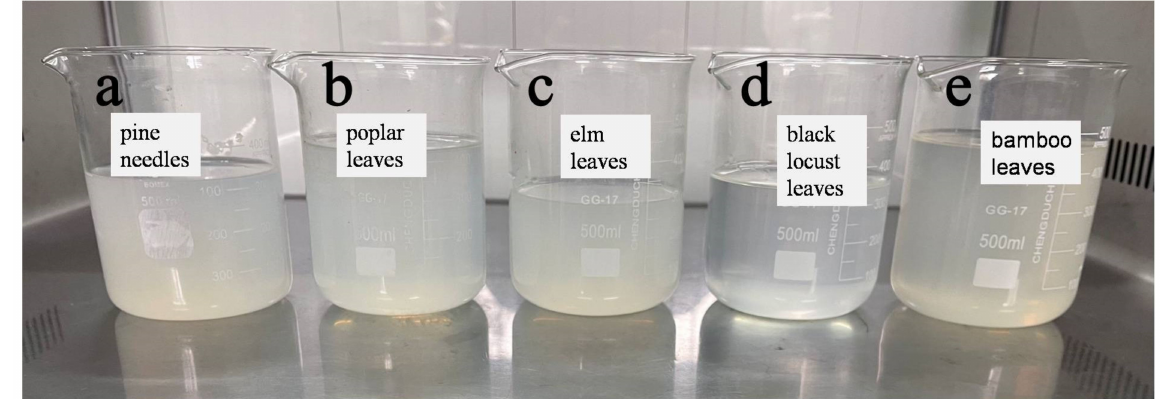
Figure 2. Photographs of CNPs dispersions prepared from ( a ) pine needles, ( b ) poplar leaves, ( c ) elm leaves, ( d ) black locust leaves, and ( e ) bamboo